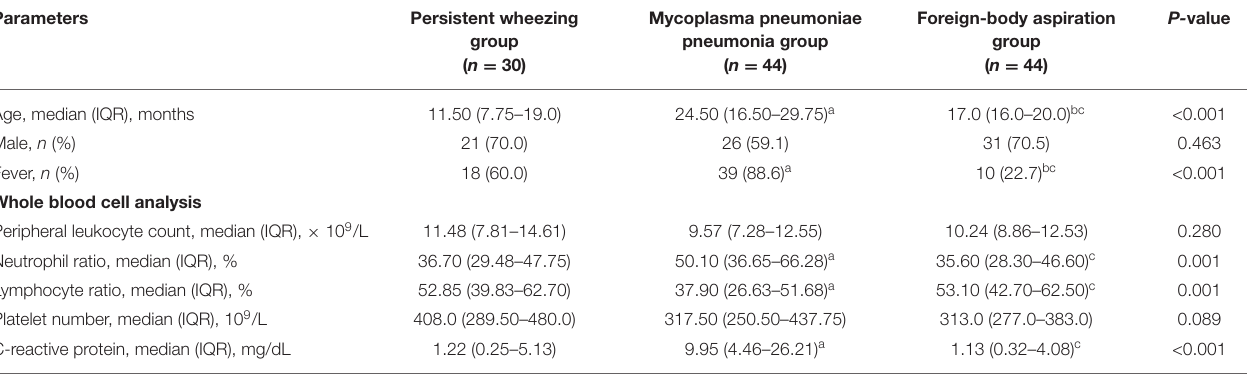
TABLE 1 | Comparison of the clinical characteristics among patients with persistent wheezing, mycoplasma pneumoniae pneumonia and foreign-body aspiration. Parameters